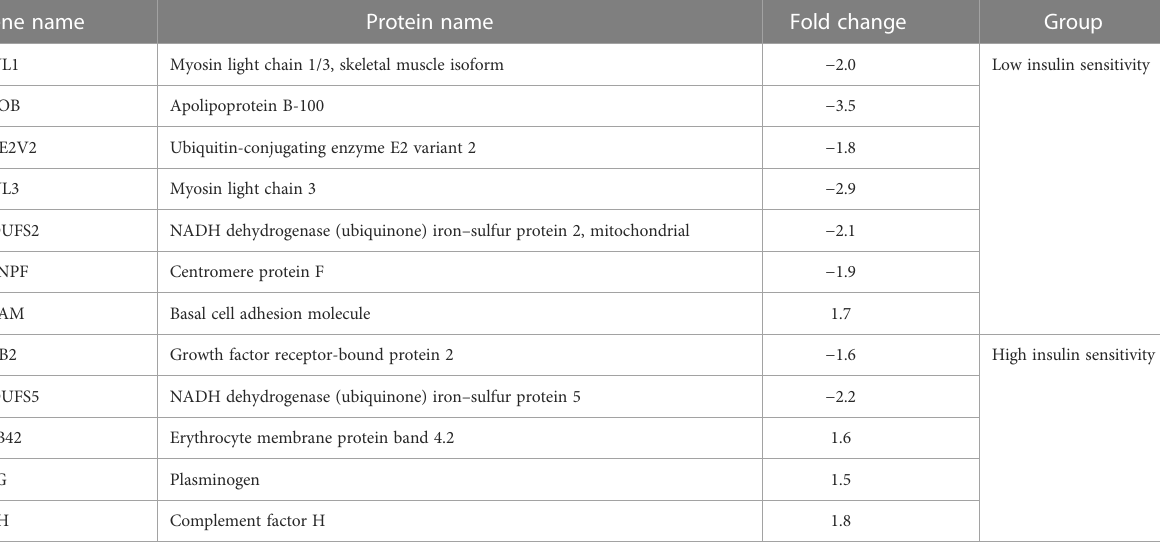
TABLE 2 Proteins showing the highest response to insulin stimulation statistically signi fi cant (p value at least <0.05) differential abundance (more than 1.5 fold) among 16 volunteers between the subjects with low insulin sensitivity (LIS) and high insulin sensitivity (HIS) both at base line and after insulin